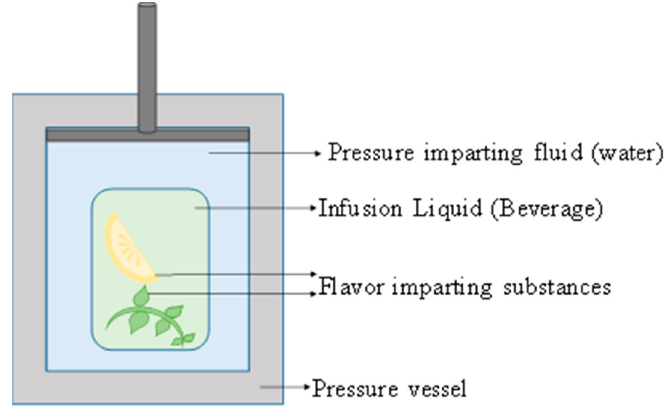
Figure 11. High pressure infusion (HPI) of flavour into beverages (redrawn from U.S. Patent No. 15/975,989, 2018 [67]).